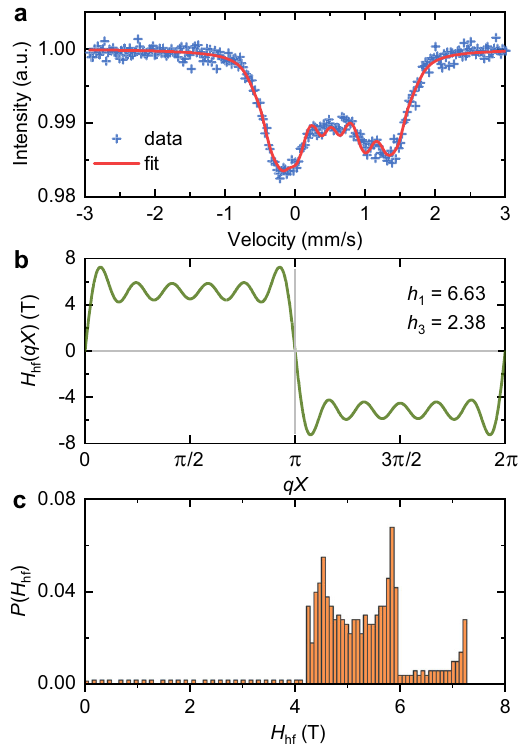
Fig. 5 57 Fe Mössbauer spectroscopy analysis on Eu 0.8 La 0.2 FeAs 2 . a The spectrum (blue crosses) obtained at 6 K and the fi t (red solid line) with the SDW model detailed in the main text. b the SDW shape, and c the resulting hyper fi ne fi eld